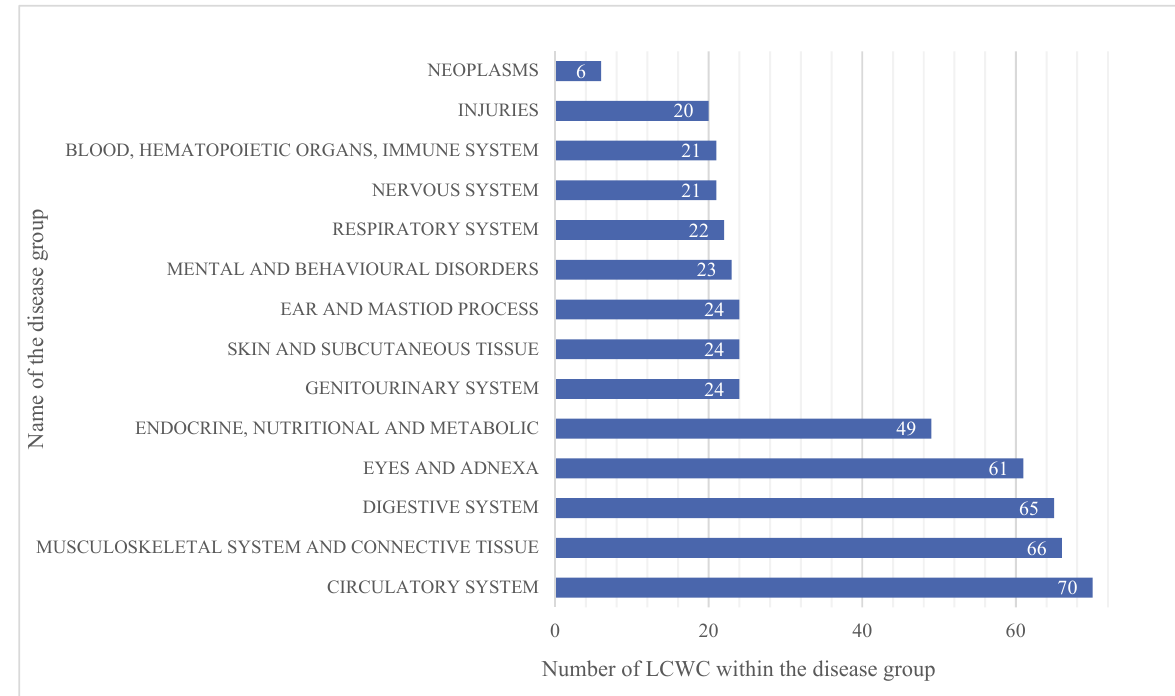
Figure 1. Distribution of the most common disease groups among the LCWC. Diseases of the following groups are the most common in the cohort of Lithuanian clean-up workers: circulatory system; musculoskeletal and connective tissues; digestive system; eyes and adnexa; and endocrine system, nutrition, and metabolism. The X -axis depicts the absolute number of LCWC within the disease groups. Some of the participants have diseases from several disease groups. The Y -axis depicts disease groups named according to the ICD-10-AM International Statistical Classification of Diseases and Related Health